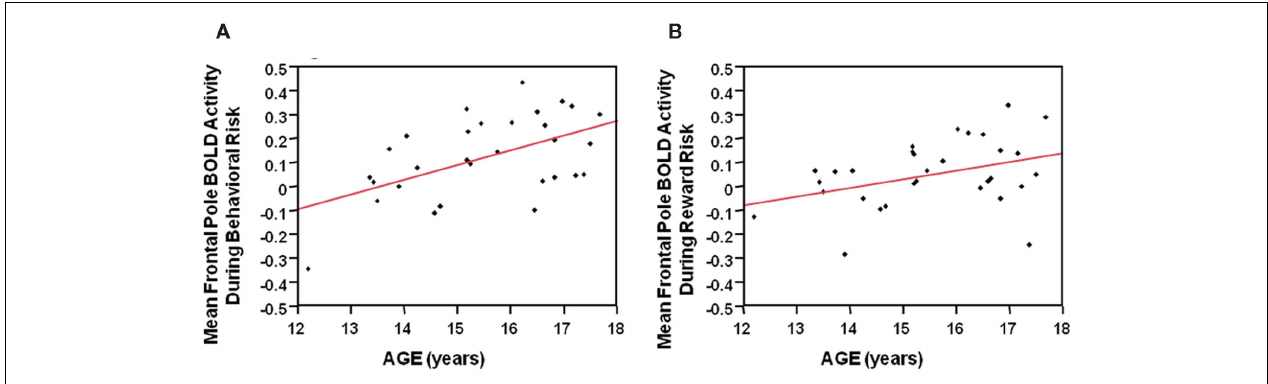
pole BOLD activity showed a positive Pearson’s correlation with age ( F = 4.7, df = 29, p < 0.04).These correlations suggest developmental differences, during two different types of decision making, in the frontal pole with increasing